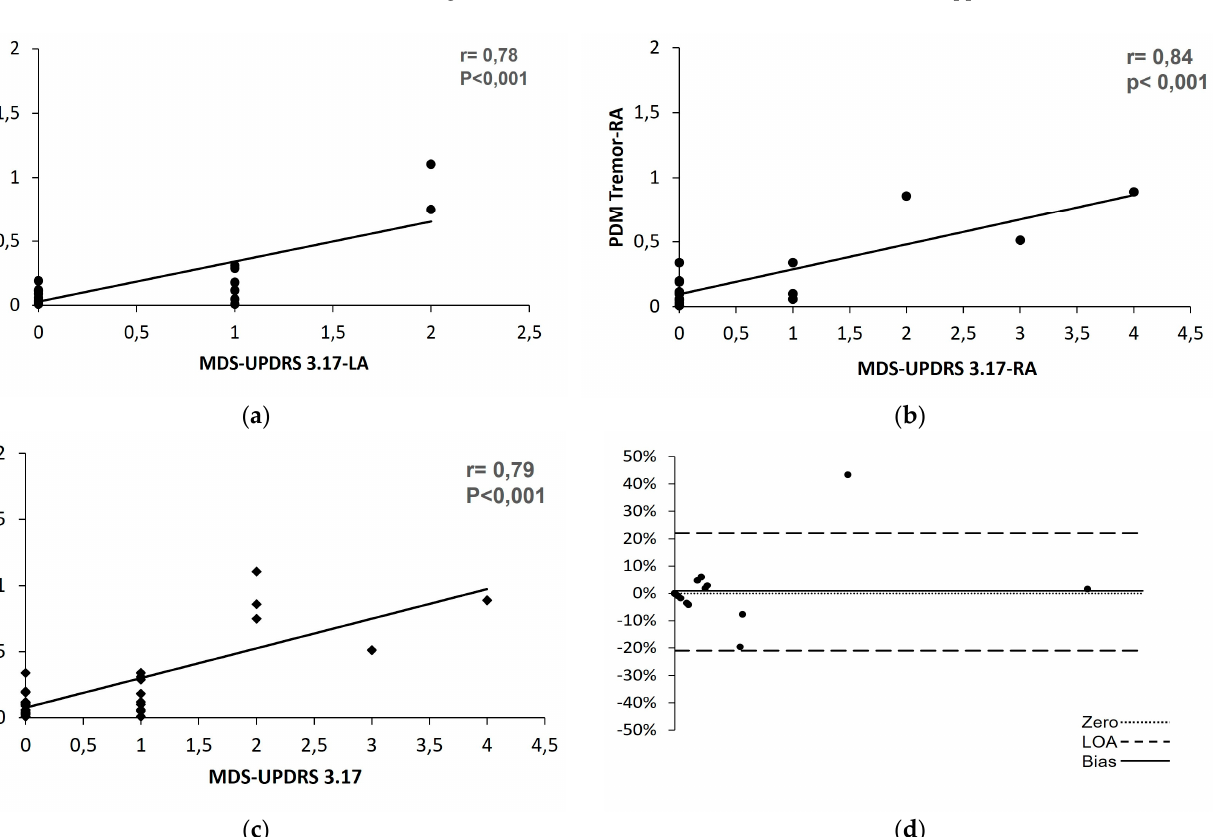
Figure 5. The correlation and agreement of the PDMonitor ® and MDS-UPDRS on resting tremor of the ( a ) left arm, ( b ) right arm, ( c ) aggregated values of both arms, and ( d ) Bland–Altman plot of the aggregated values.